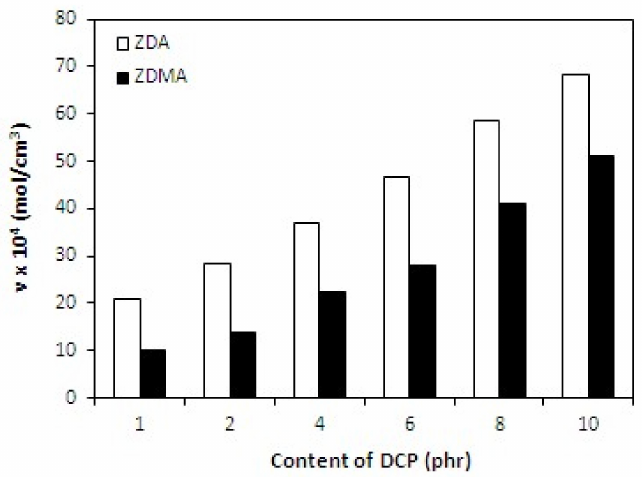
Figure 13. Influence of peroxide content on cross-link density ν of composites.